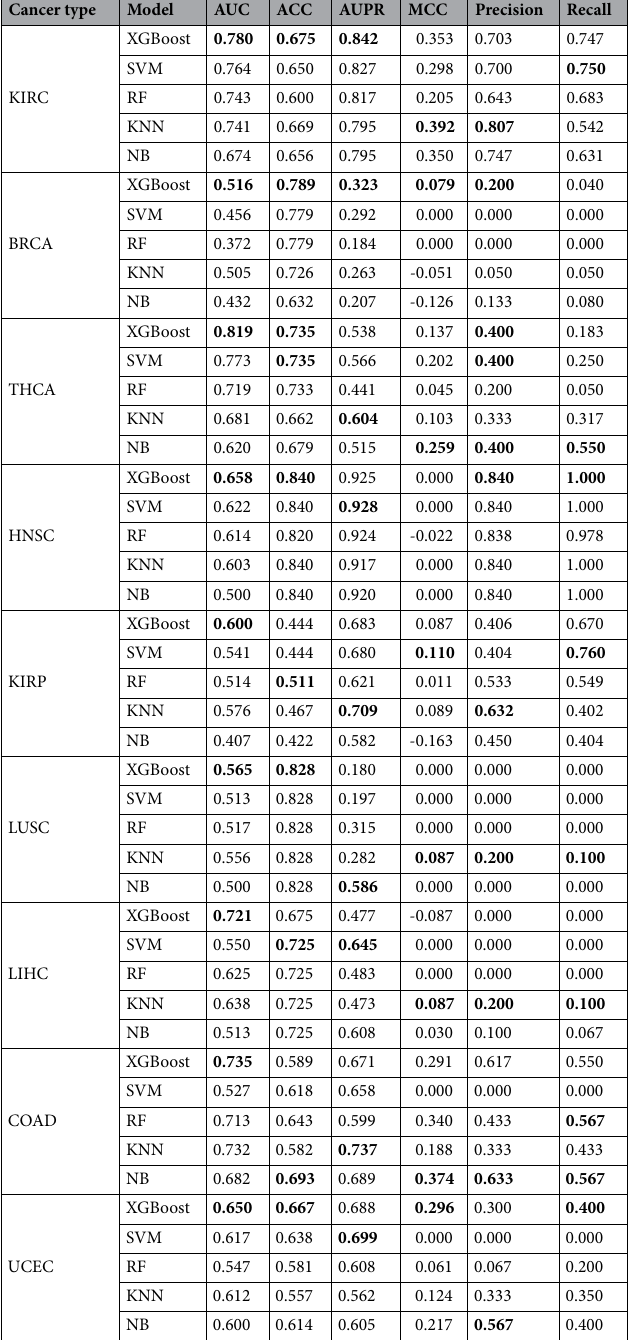
Table 1. Comparison of prediction performance of different classification models on different datasets. KIRC kidney renal clear cell carcinoma, BRCA breast invasive carcinoma, THCA thyroid carcinoma,